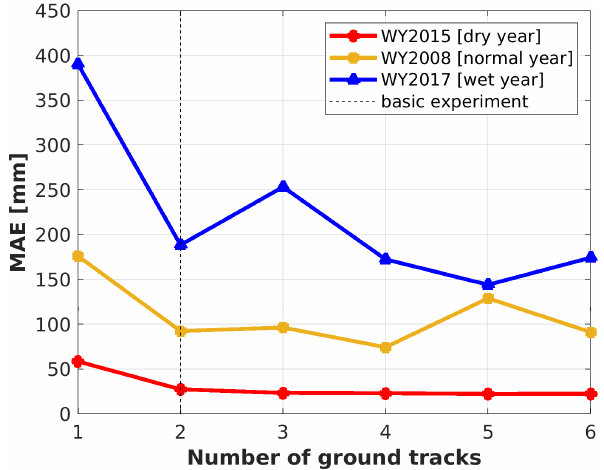
Figure 11. Changes in MAE (mm) of the DNN-based inferred 1 April SWE in dry (WY2015; red dots), normal (WY2008; yel- low square points) and wet years with the number of ground tracks. The dashed lines for the number of ground tracks equal to 2 indi- cate that the addition of more satellite overpasses do improve the estimates much (see also Sect.